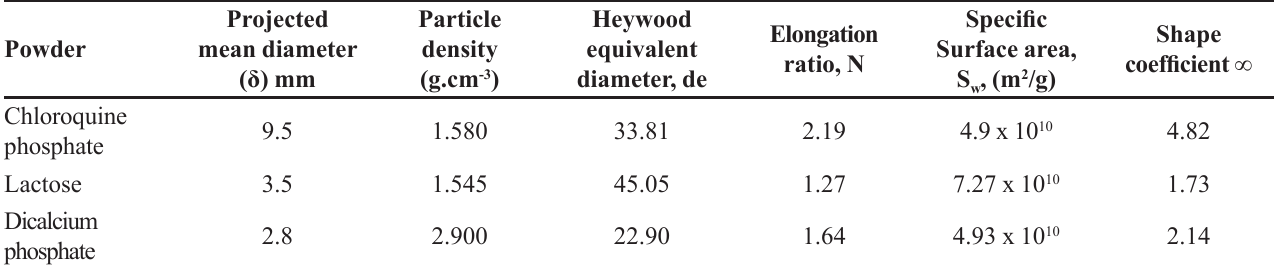
TABLE I - Particle and geometric properties of individual powders